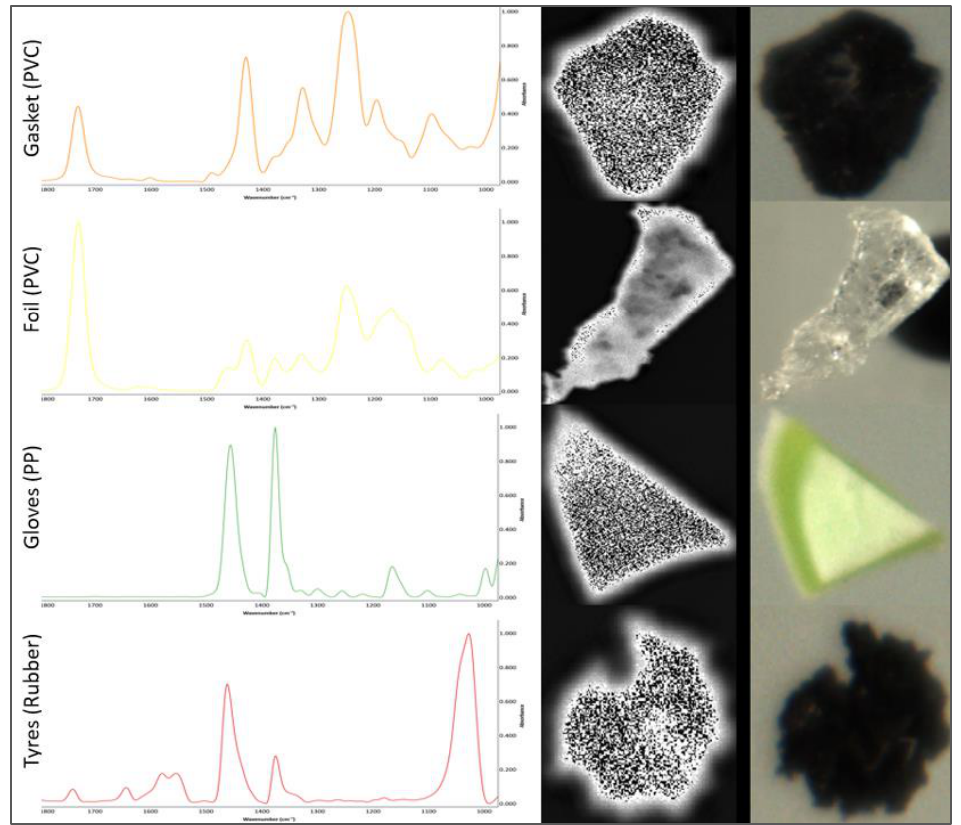
Figure 1. Visual images IR spectra ( left ) and visual images ( right ) of microplastics analyzed. The characteristics of the exemplary particles analyzed, in terms of size and shape, are presented in Table 5. Values of parameters such as solidity or circularity are presented. Solidity is the ratio of the actual surface area of an object to the surface area constituted by a thread stretched around the particle. Circularity, on the other hand, determines how close a given particle shape is to a perfect circle. Table 5. Parameters of selected particles.